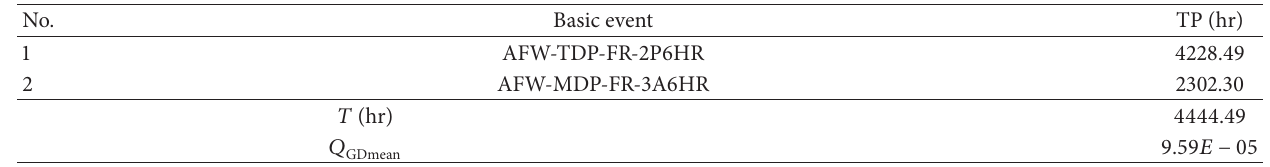
Table 6: Obtained optimal test placement times for case scenario 1.